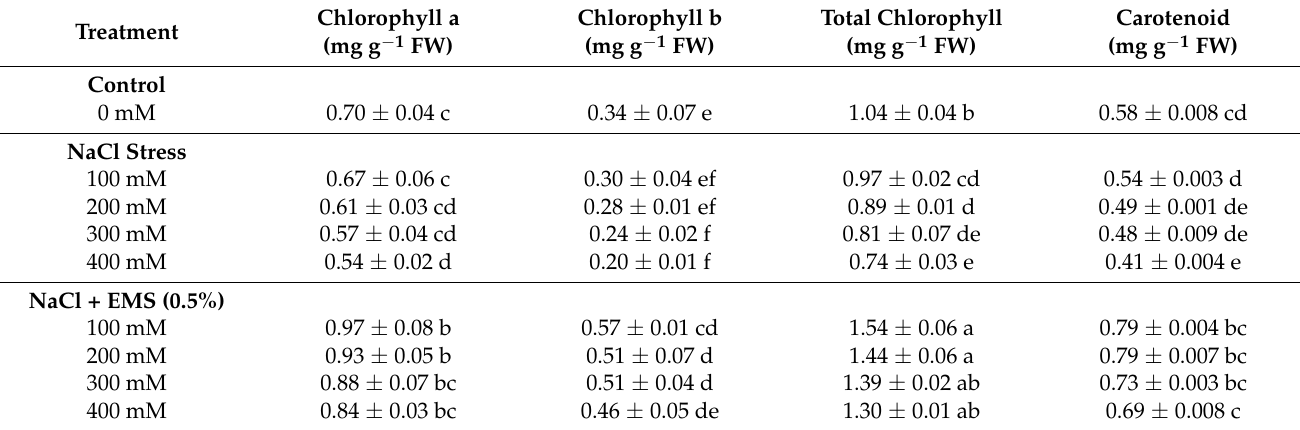
Table 1. Mutagenic effect of sodium chloride (NaCl) and ethyl methane sulphonate (EMS) on photosynthetic pigments of callus of A. vulgaris. The values reflect the mean standard deviation of three independent experiments. According to DMRT, means separated by different letters are significantly different from each other at 5% level of significance ( p ≤ 0.05).